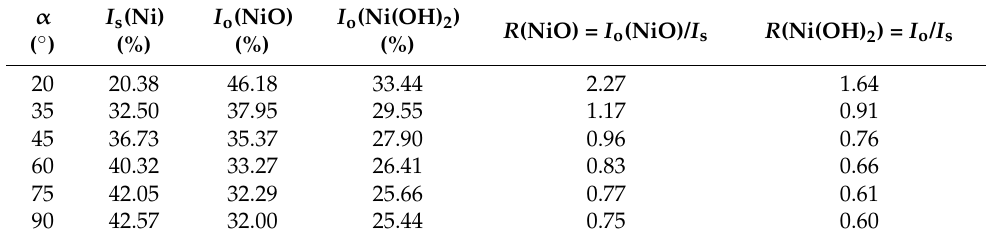
Table 2. Relative peak intensities ( I s and I o ) and the I o / I s ratios for both nickel oxides in the NiFe (100 nm) thin film.